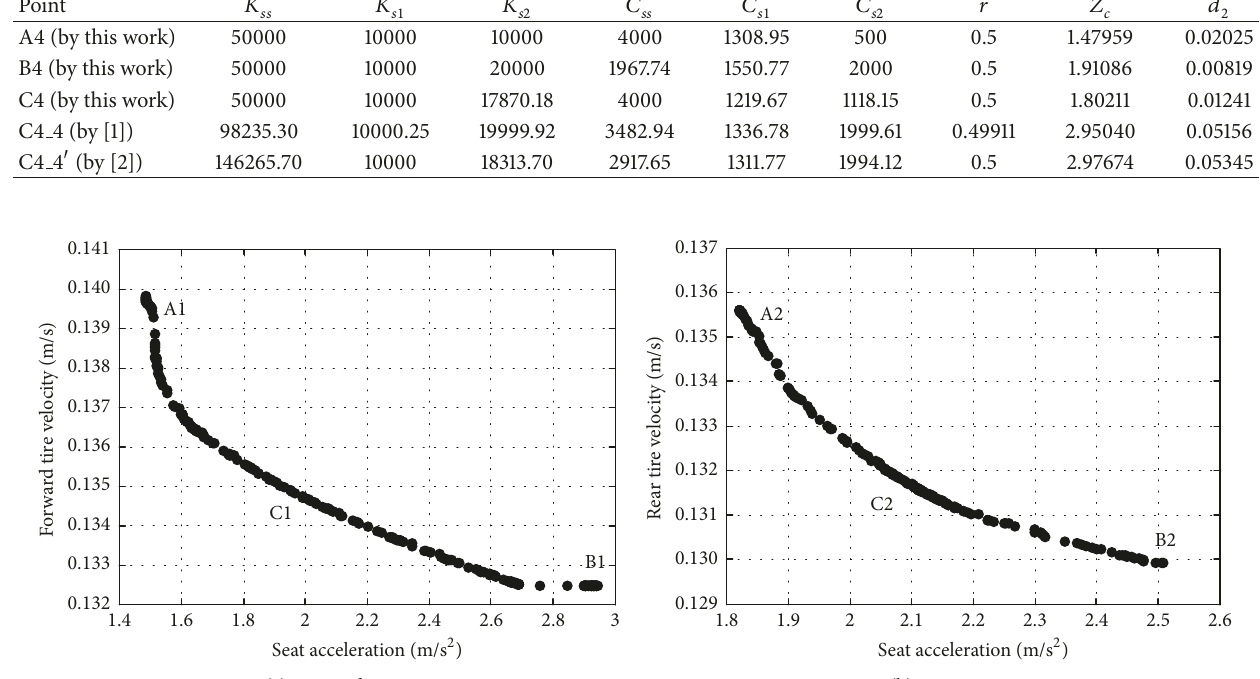
Table 8: Objective function values and trade-off design variables of [1, 2] and this work shown in Figure 16. Point